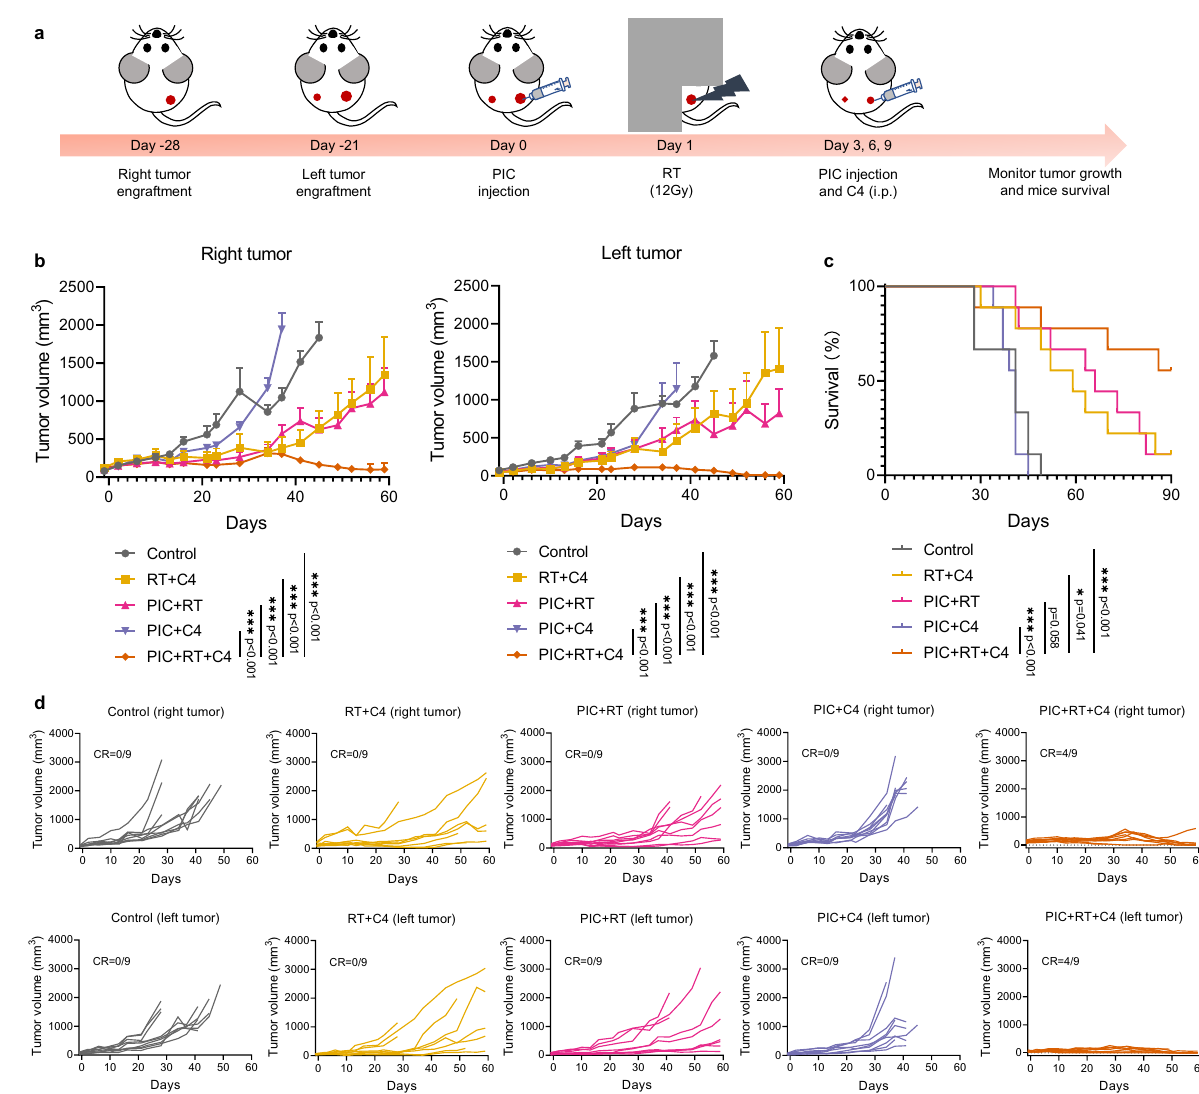
Fig. 7 | The systemic anti-tumor immune response induced by PIC+RT+anti- CTLA-4(C4).a SchemeforthestudyoftheabscopaleffectofPIC+RT+anti-CTLA- 4. b Averagetumorgrowthcurvesofbothrightandlefttumor,and c survivalrateof mice after the indicated treatment regimen. ( n =9 biologically independent ani- mals). d Individual tumor growth curves in b . CR: complete response. C4: anti- CTLA-4. i.p.: intraperitoneal injection. PIC: 140 μ g/100 μ L/dose. C4: 100 μ g/100 μ L/